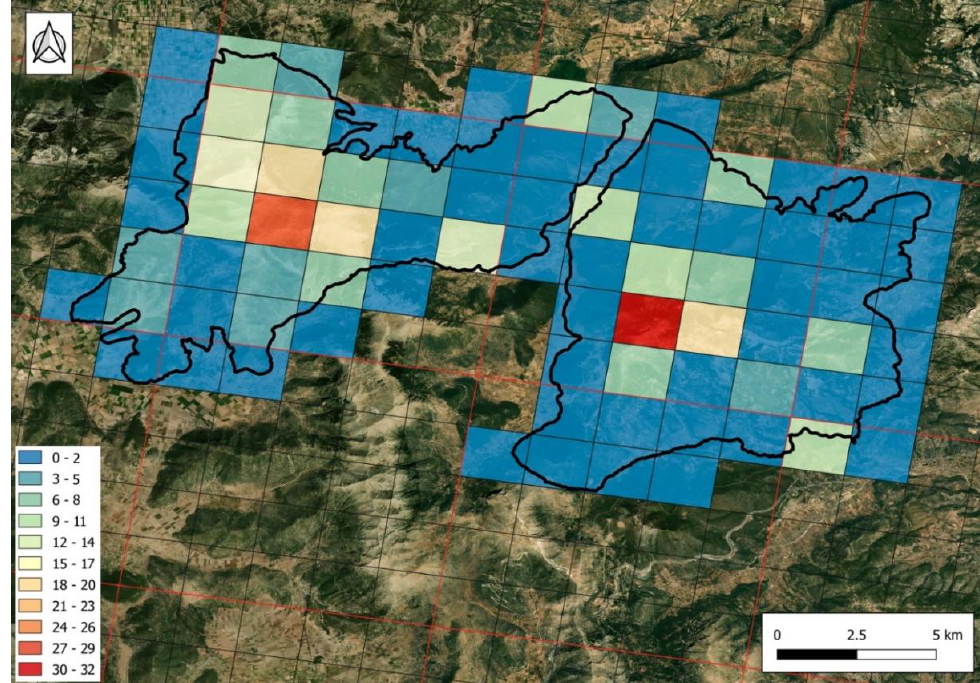
Figure 1. Number of Greek endemic taxa (depicted with color scale) recorded in each of the 2 × 2 km grid cells on Mts. Oligirtos and Farmakas. The study area (black line) and 10 × 10 km European Environment Agency (EEA) grid (red line) are also indicated. Grid cells covered less than 0.2% (i.e., 8000 m 2 ) of the study area have been